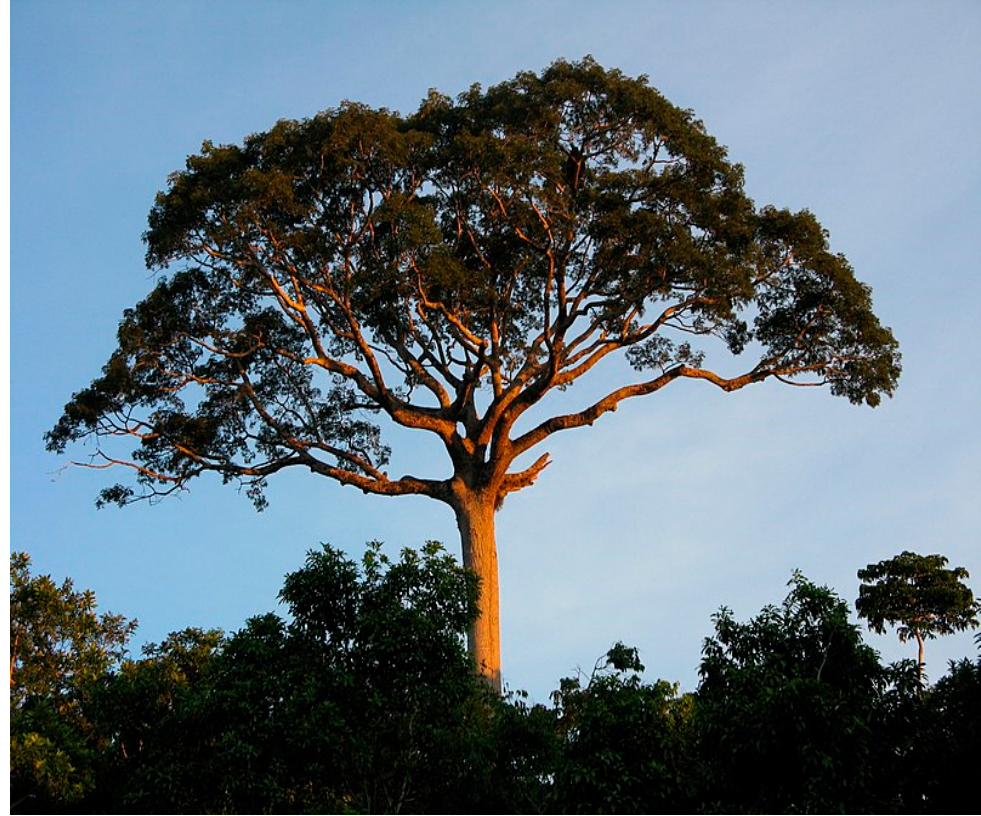
Figure 1. Photo by Klaus Schönitzer, “Ein Lupuna-Baum ( Ceiba pentandra ), das Wahrzeichen